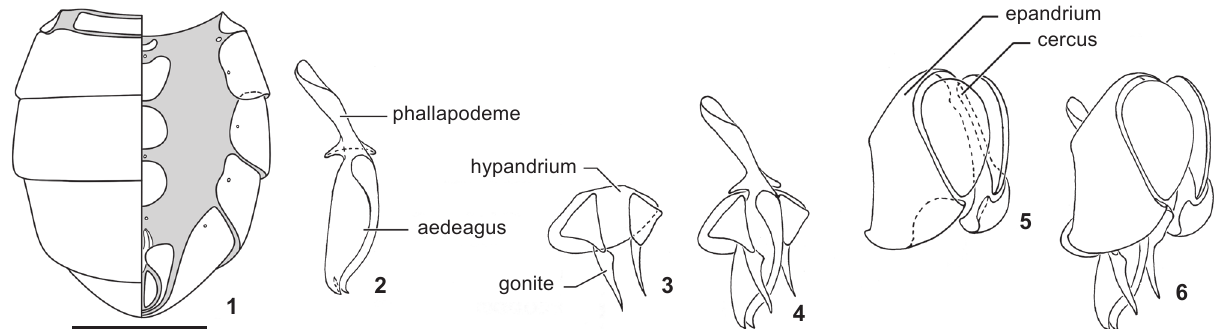
Figures 1-6. Parydra nigripes : (1) abdomen of male, dorsal and ventral views; (2) aedeagus and phallapodeme, latero-oblique view; (3) gonite and hypandrium, latero-oblique view; (4) gonite, hypandrium, phallapodeme, latero-oblique view; (5) epandrium and cercus, latero-oblique view; (6) male terminalia, latero-oblique view. Scale bars: 1 = 0.5 mm; 2-6 = 0.25